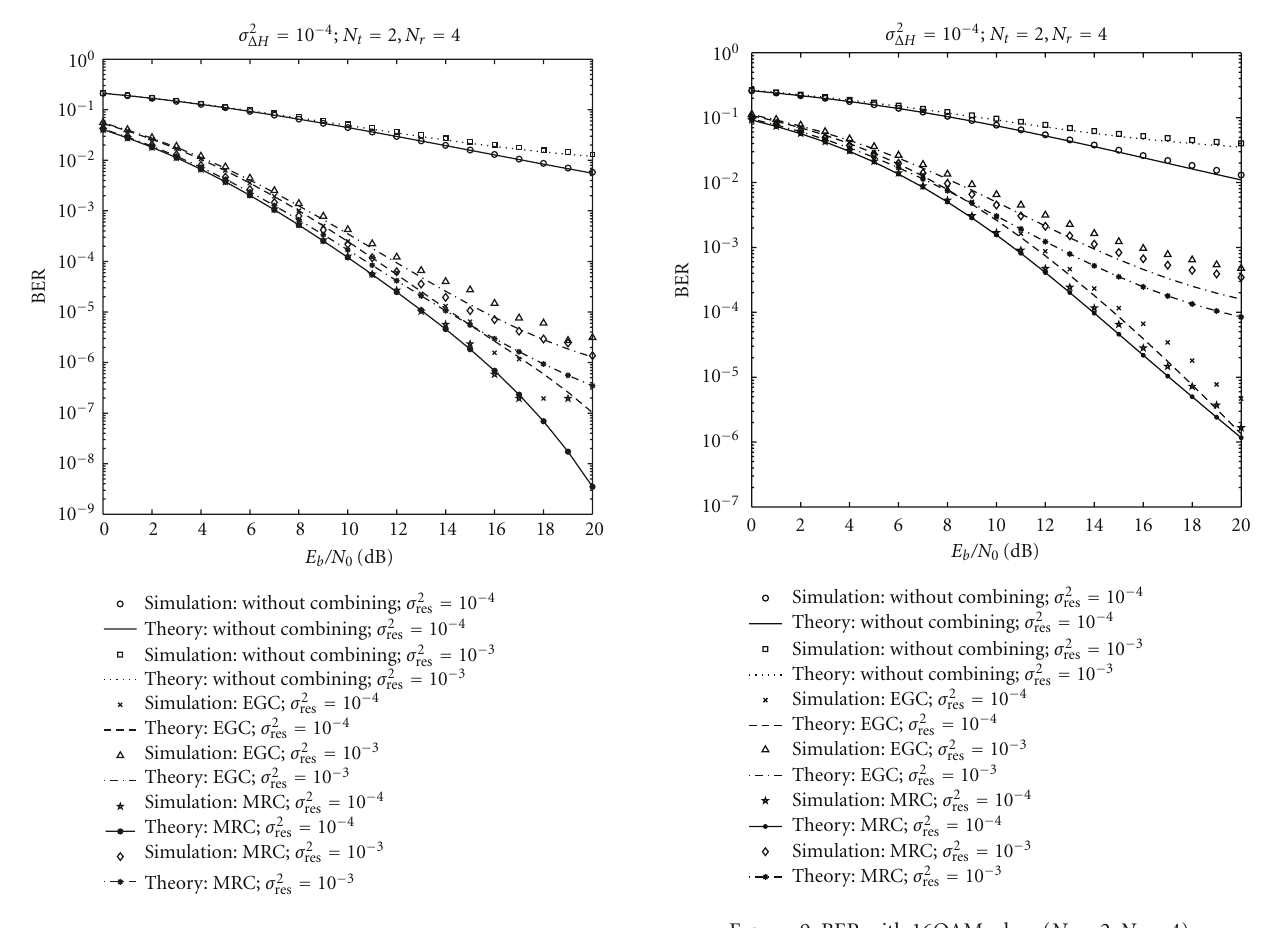
Figure 8: BER with QPSK when ( N t = 2, N r = 4). Figure 9: BER with 16QAM when ( N t